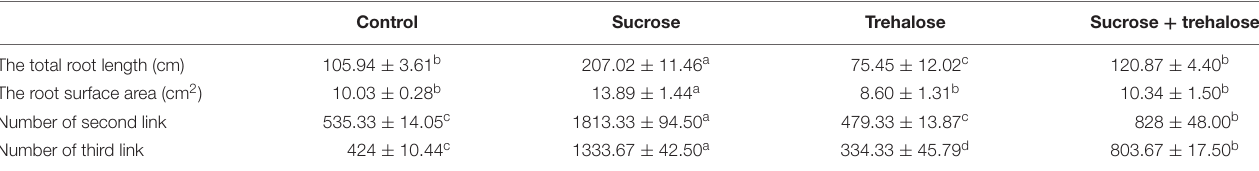
TABLE 3 | Effects of different treatments on the root architecture of peach seedlings.